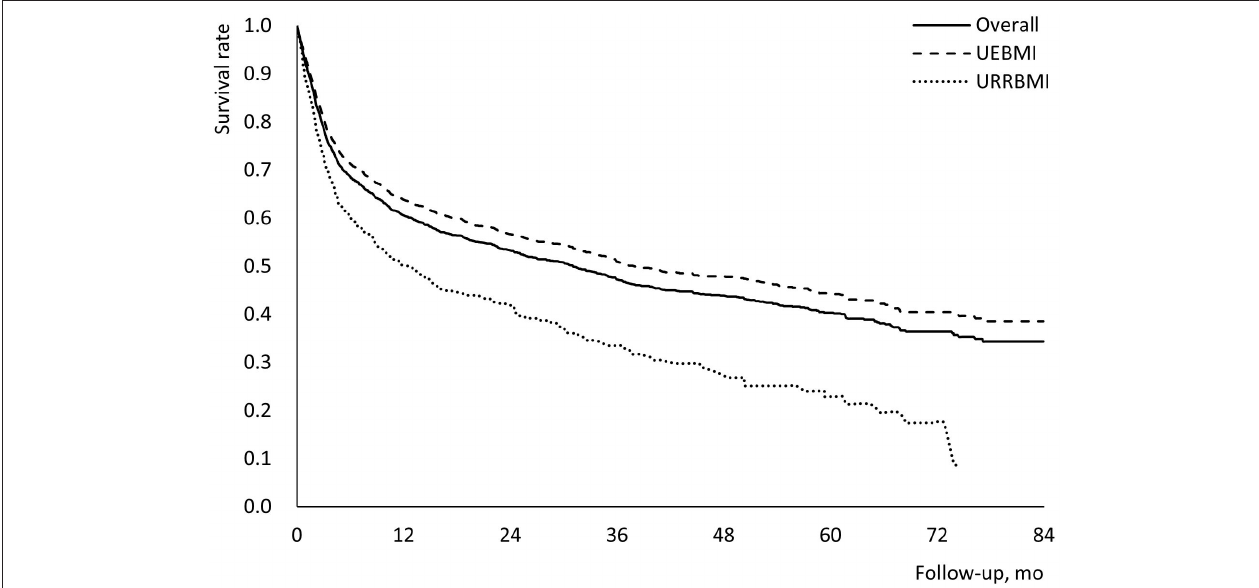
FIGURE 2 | Kaplan-Meier survival curves for patients with HCC during the follow-up period. UEBMI, Urban Employee Basic Medical Insurance; URRBMI, Urban and Rural Resident Basic Medical Insurance; HCC, hepatocellular carcinoma.